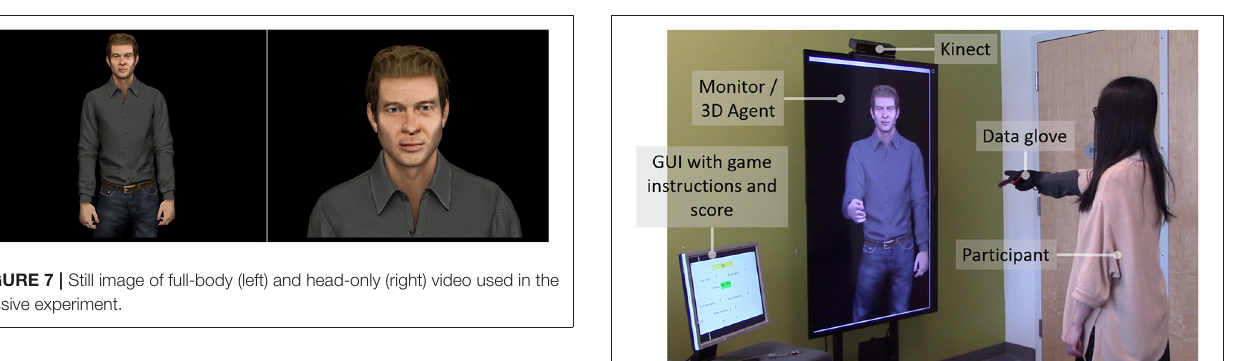
FIGURE 8 | Participant interacting with the virtual human during the Rock-Paper-Scissors game for the interactive evaluation. with a TIPI in which participants rated the extent to which the pair of traits applied to themselves. The experiment took, on average, approximately 30 min to complete. The experiment